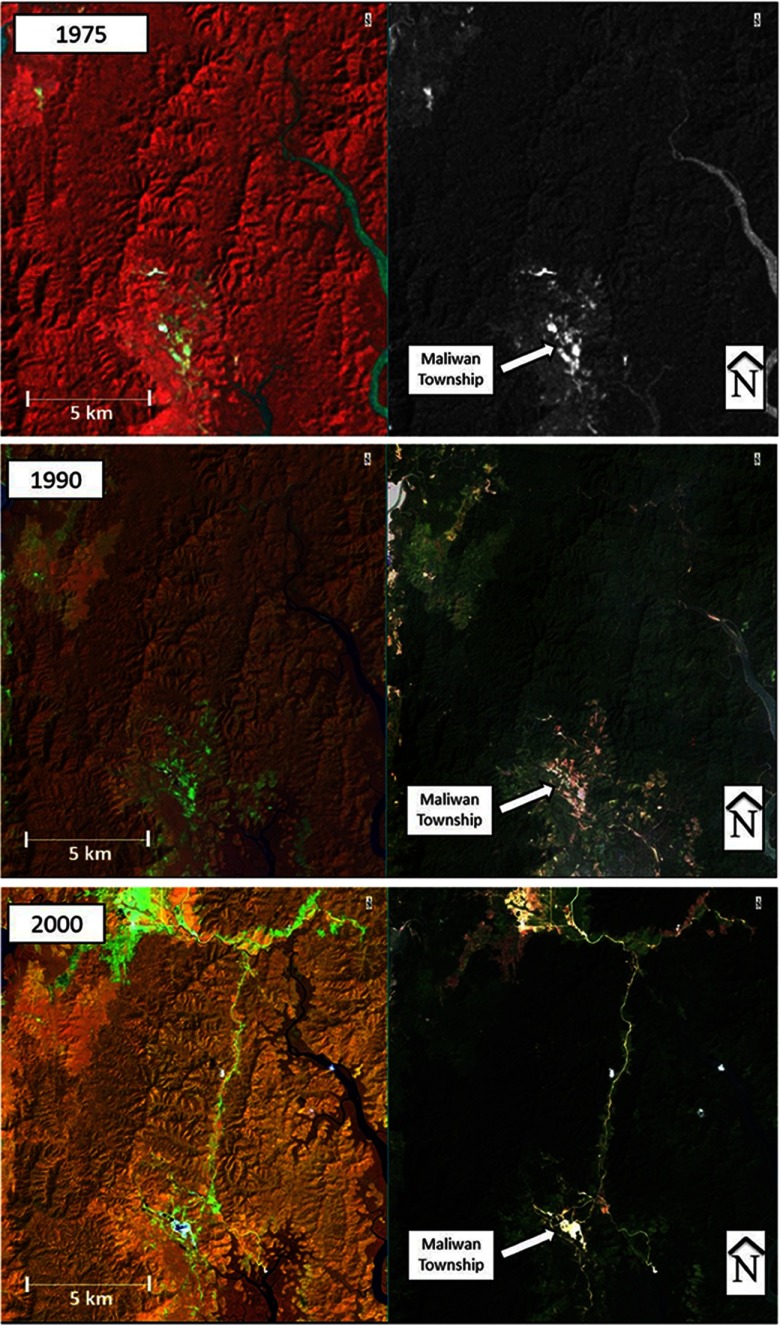
Remote Sensing Vegetation Analysis, 1975–2015In each set of maps, the rightmost map is the natural color model and the leftmost map is the false color model. 1975: There appears to be little deforestation surrounding Maliwan Township and virtually none in the forested lands to the north. 1990: Surrounding deforestation near Maliwan Township appears to have increased. 2000: A marked increase in deforestation is evident. 2005: Since 2000, the road system has split into 2 main segments and smaller forays into the mountainside branch off of the main road. 2010: The road system is now flanked by cleared land on both sides. 2015: Deforestation has encroached on vast areas of once natural forestland. The road systems have evolved into complex and planned transport infrastructure.